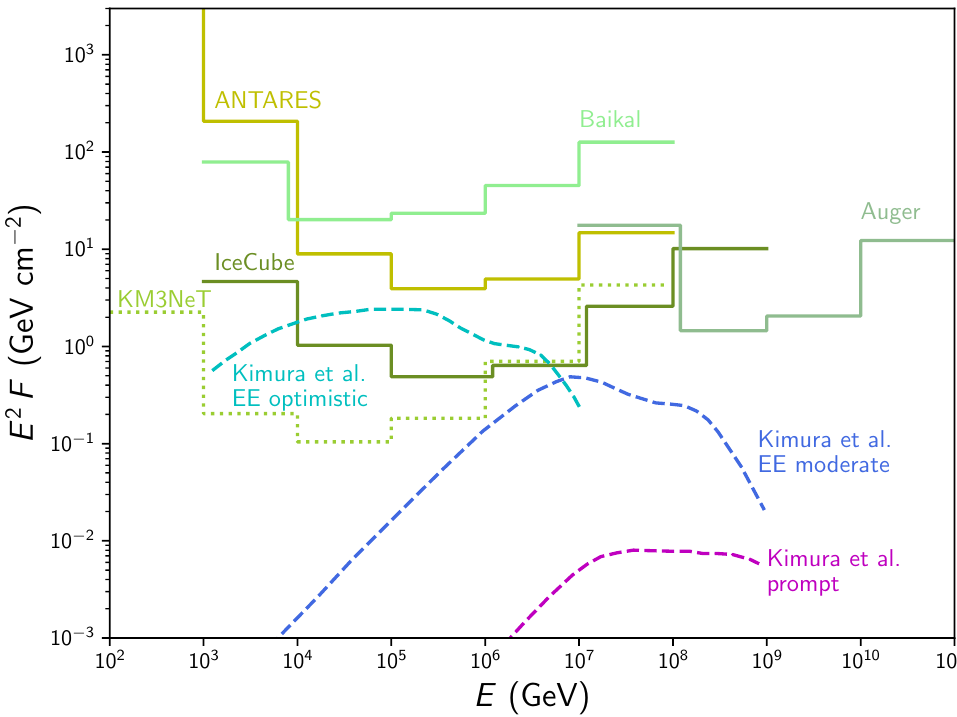
Figure 4. Fluence upper limits per flavour on the high-energy neutrino emission from experimental data assuming a 500 s time window around the GW170817 event [87]. Baikal limits are from ± Ref. [88]. KM3NeT preliminary sensitivity, computed for an optimal zenith angle, is from Ref. [44]. Theoretical models for comparison are from Ref. [83]. Figure taken from Ref.